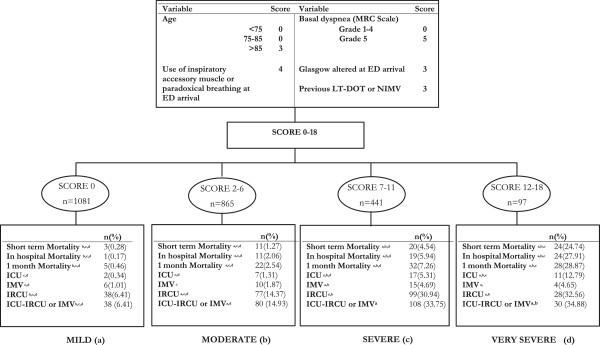
Death in exacerbation of chronic obstructive pulmonary disease: construction of continuous and categorical scores and relation with different outcomes. ICU: Intensive Care Unit, IMV: Invasive mechanical ventilation, IRCU: Intermediate Respiratory Care Unit, LT-HOT: Long-term home oxygen therapy, NIMV: Noninvasive mechanical ventilation. Superscript letters indicated statistical significant differences among the DeCOPD risk classes for the outcomes displayed.